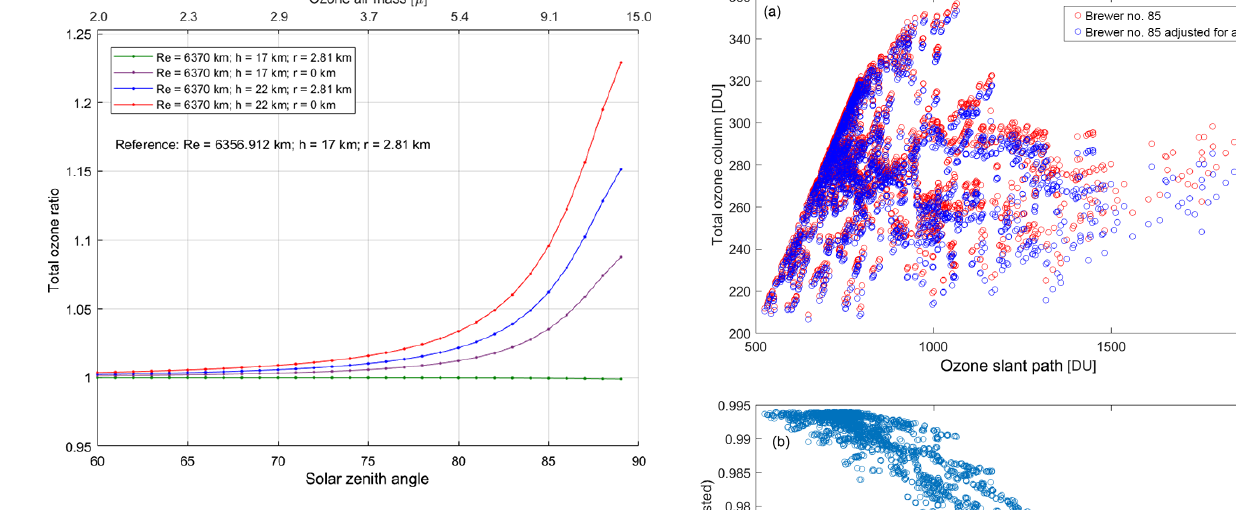
Figure 7. The ratio of total ozone retrieved from modeled Dobson using air mass factors calculated with a mean value for the radius of the Earth, R e = 6370km as used in the Brewer retrieval, and differ- ent values for the altitude of site, r , and the height of ozone layer, h , to the ozone values retrieved using air mass factors calculated for the South Pole employing R e = 6356 . 912km, r = 2 . 81km, and h = 17km as a reference. Any discrepancy in the air mass is di- rectly reflected in the Dobson and Brewer retrieved total ozone via Eqs. (3) and (9), respectively.